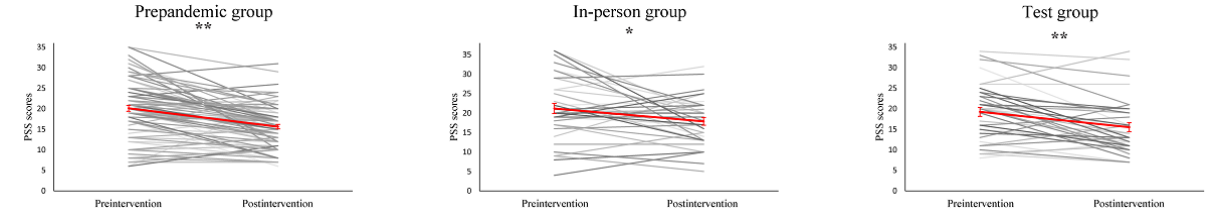
Figure 3. Change in perceived stress. Black lines depict change for individual participants, and red line indicates the mean change and standard errors in the group. Change in perceived stress from pre- to post-intervention is equivalent among the three groups. PSS = perceived stress scale; * P <.05; ** P <.001.